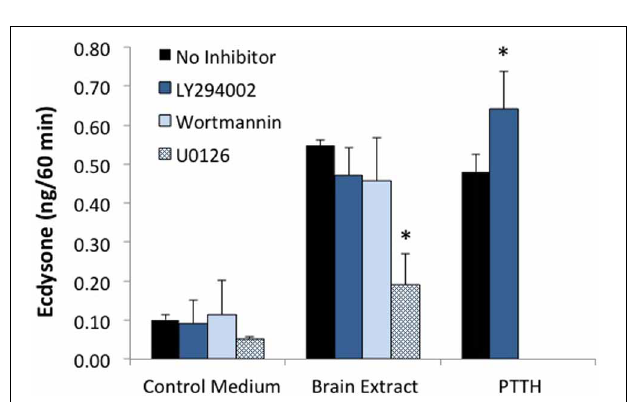
FIGURE 5 | Effects of PI3K inhibitors (LY294002 and wortmannin), and MEK inhibitor (U0126) on ecdysone secretion. Prothoracic glands from day 3 fifth instar larvae were incubated for 20min in medium with or without the designated inhibitor, followed by 60min in one of the following treatments: No Inhibitor (Grace’s medium); LY294002 (60uM); Wortmannin (10uM); U0126 (10uM); Brain Extract (0.5 brain equivalents/30ul); Brain Extract + LY294002; Brain Extract + Wortmannin; Brain Extract + U0126; PTTH (7nM); or PTTH + LY294002. At the end of the 60min incubation period, culture medium was assayed for ecdysone by radioimmunoassay. Ecdysone secretion by groups treated with U0126 was significantly lower than by groups in the respective no-inhibitor controls (asterisks) (ANOVA, Tukey–Kramer post-hoc test, significance p < 0 . 05). Sample sizes were as follows (glands per group): Control = 51; BE = 38; LY294002 = 36; BE + LY294002 = 27; U0126 = 4; BE + U0126 = 5; Wortmannin = 10; BE + Wortmannin = 12; PTTH = 19; PTTH + LY =